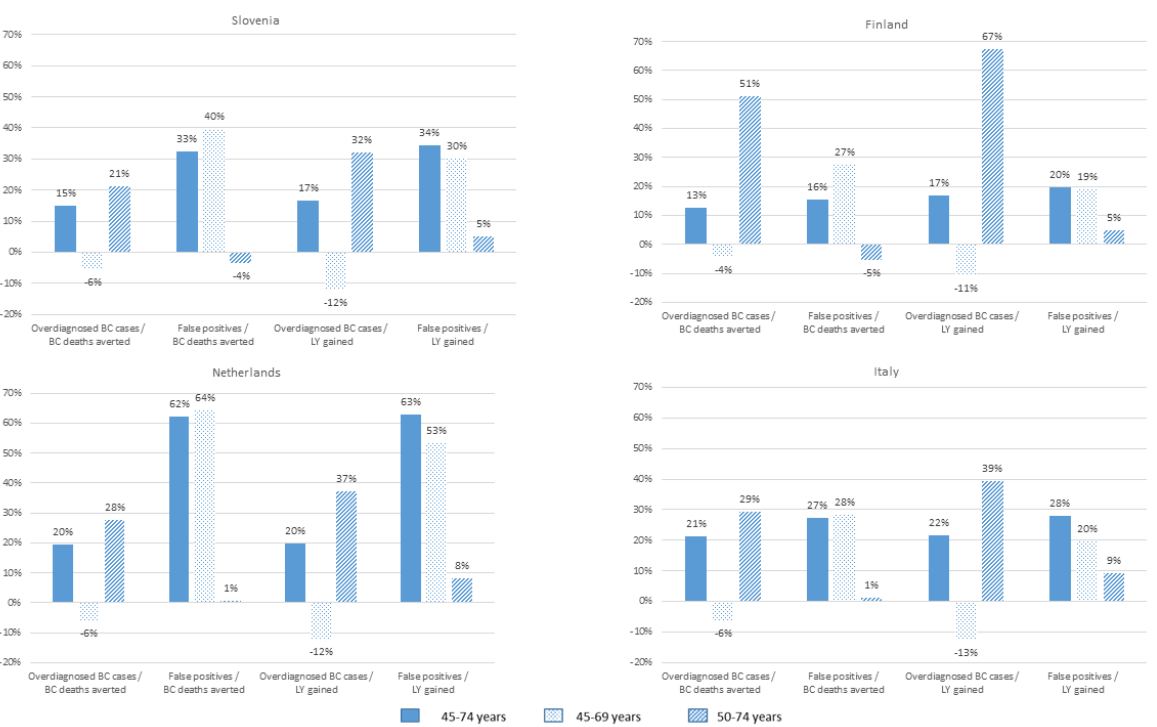
Figure 1. Percentage change in harm-to-benefit ratios in comparison to the reference strategy of ages 50–69, per alternative screening strategy and country. BC: breast cancer; LY: life years.